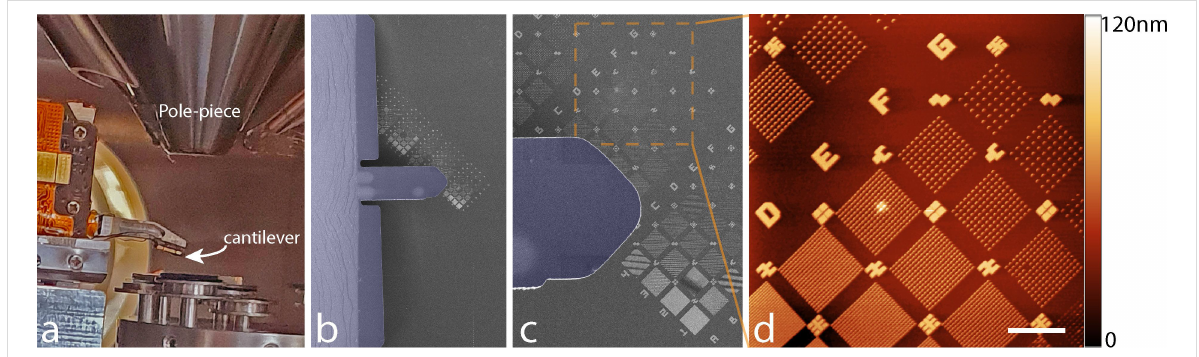
Figure 2: Correlative imaging in process on silicon pillars. a) Optical image showing how the AFM cantilever is positioned at the end of a low-profile, overhanging structure, which fits between the pole piece and the sample. b, c) The cantilever (colorized in purple on the HIM images) can be navi- gated by making use of the large FOV image provided by the HIM. d) AFM height image of Si nanopillars taken in off-resonance tapping mode. Scale bar 5 µm.